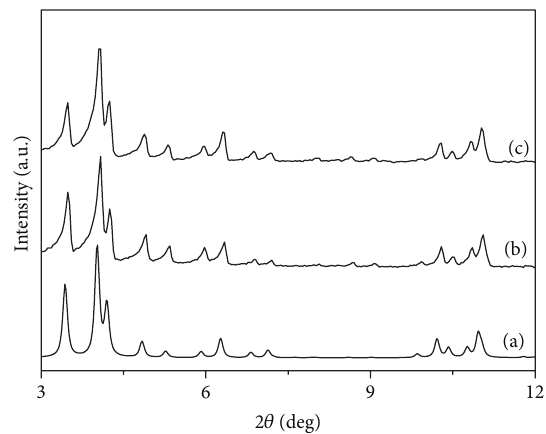
Figure 1: XRD patterns of the simulated MIL-100(Fe) (a), the fresh MIL-100(Fe) (b), and the one after one month (c).